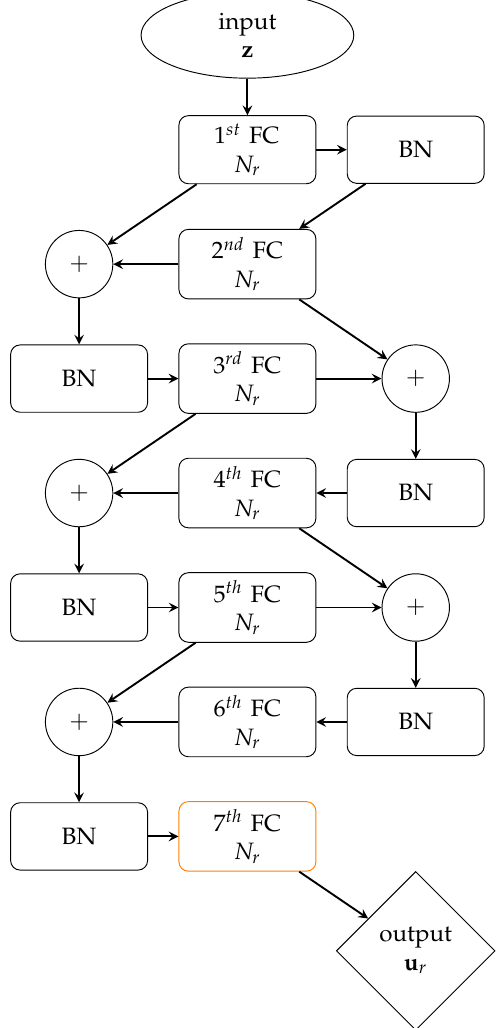
Figure 5. Architecture of the regression model; as for the notation, see the caption of Figure